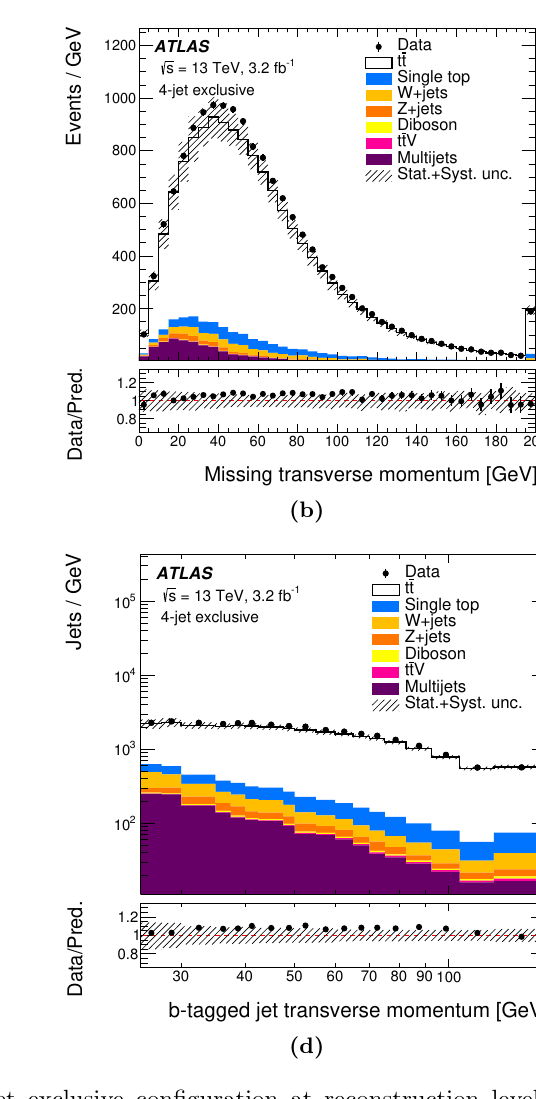
Figure 1 . Kinematic distributions in the 4-jet exclusive con(cid:12)guration at reconstruction level: (a) lepton transverse momentum, (b) missing transverse momentum, transverse momentum of (c) the selected jets and (d) of the selected b -tagged jets. Data are compared to the sum of signal and background predictions using the nominal sample as the t (cid:22) t signal model. The hatched area indicates the combined statistical and systematic uncertainties in the total prediction, excluding systematic uncertainties related to the modelling of the t (cid:22) t production. Events beyond the range of the horizontal axis are included in the last